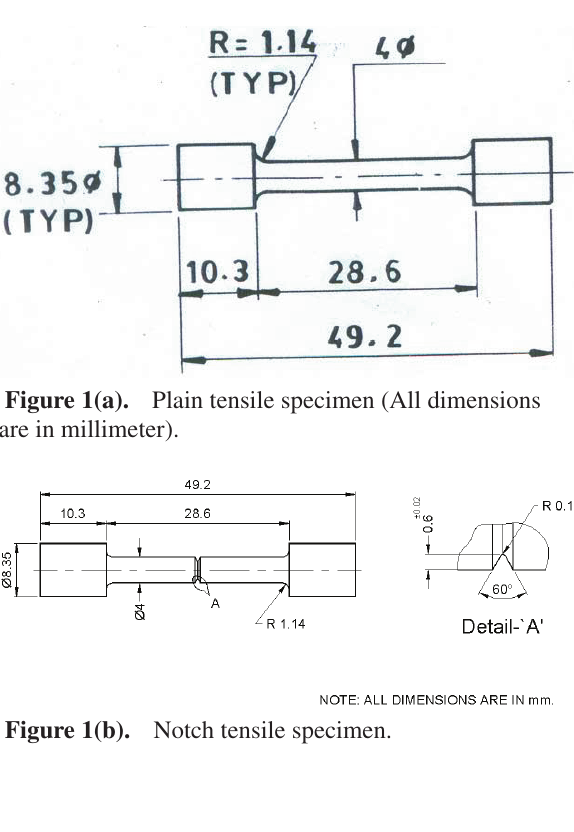
Table 1. Chemical composition of four heats of 316LN SS [in mass%].